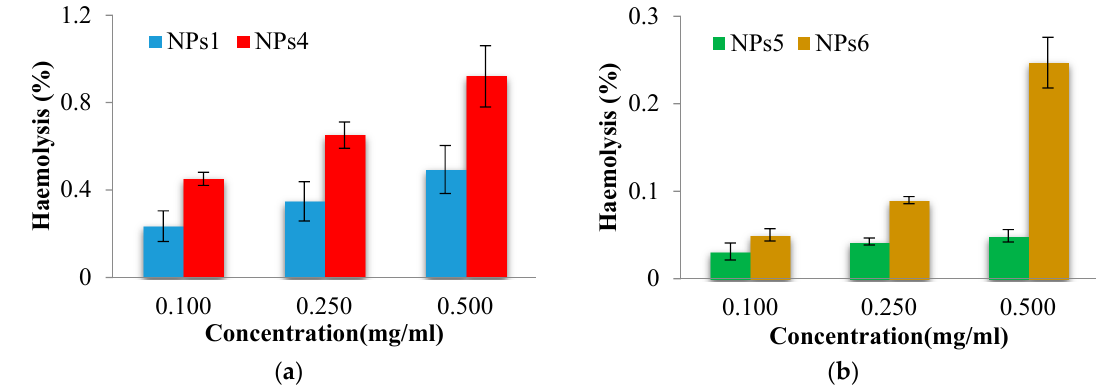
Figure 3. In vitro hemolysis assay for drug free and drug-loaded PNVP ( a ) and PCL-based ( b ) NPs.